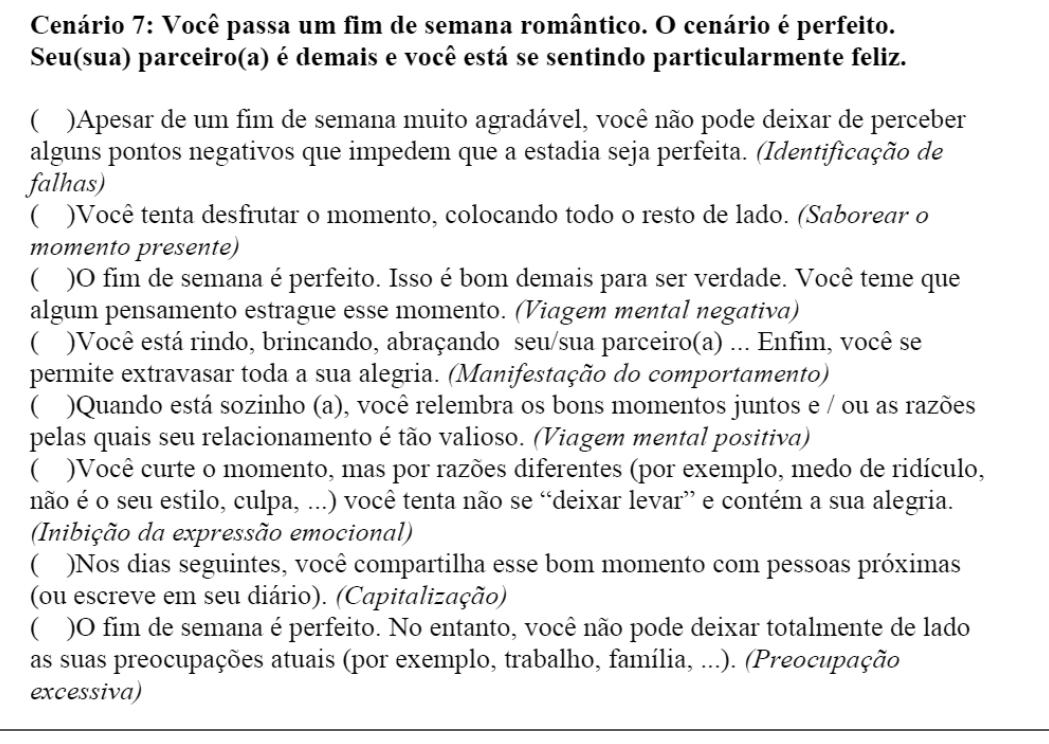
Figura 1. Exemplo de cenário de alegria com as opções de estratégias.